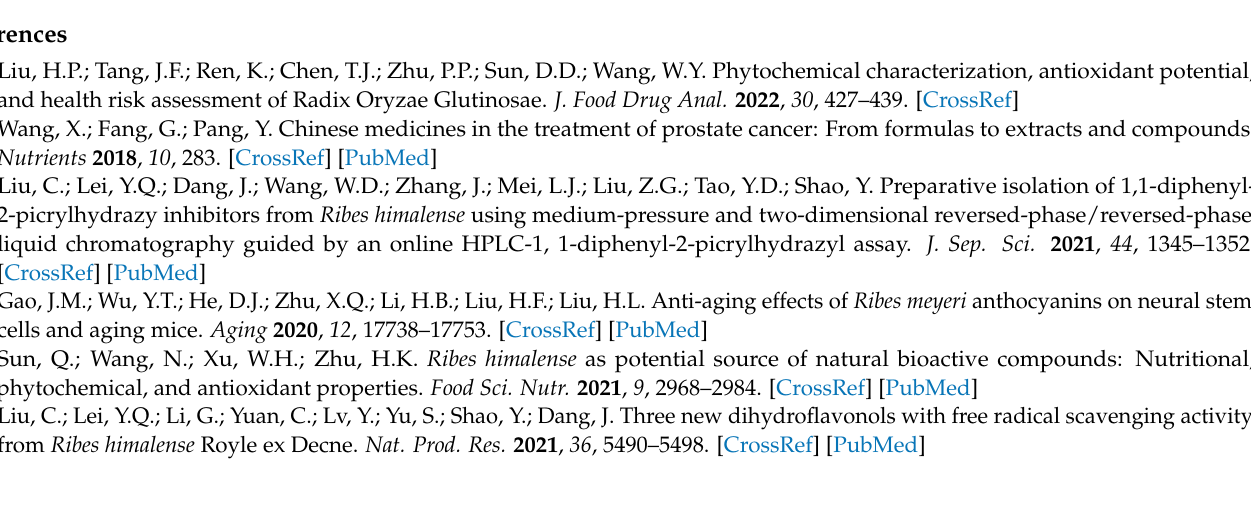
Figure S2: 1 H NMR (600 MHz) data of Fr3-1-1 (in CD 3 OD). Figure S3: 13 C NMR (151 MHz) data of Fr3-1-1 (in CD 3 OD). Figure S4: ESI-MS spectrum of Fr3-1-2. Figure S5: 1 H NMR (600 MHz) data of Fr3-1-2 (in CD 3 OD). Figure S6: 13 C NMR (151 MHz) data of Fr3-1-2 (in CD 3 OD). Figure S7: ESI-MS spectrum of Fr3-1-3. Figure S8: 1 H NMR (600 MHz) data of Fr3-1-3 (in CD 3 OD). Figure S9: 13 C NMR (151 MHz) data of Fr3-1-3 (in CD 3 OD). Figure S10: ESI-MS spectrum of Fr3-1-4. Figure S11: 1 H NMR (600 MHz) data of Fr3-1-4 (in CD 3 OD). Figure S12: 13 C NMR (151 MHz) data of Fr3-1-4 (in CD 3 OD). Figure S13: Interaction of Fr3-1-1 with active sites of nine potential target proteins. Figure S14: Interaction of Fr3-1-2 with active sites of nine potential target proteins. Figure S15: Interaction of Fr3-1-3 with active sites of nine potential target proteins. Figure S16: Interaction of Fr3-1-4 with active sites of nine potential target